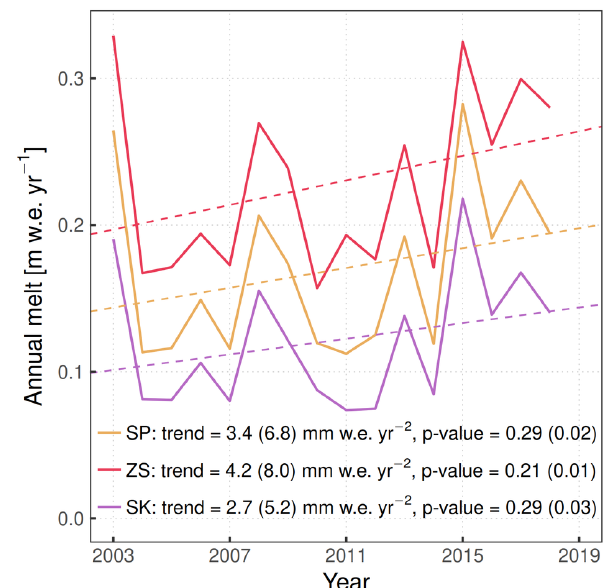
Figure 10. Time series of modeled annual melt amounts at three representative grid cells (solid lines; SP: saddle point, SK: Sig- nalkuppe slope, ZS: Zumsteinspitze slope). Linear least-squares fits (each including n = 16 annual values) are shown as dashed lines. Reported annual melt trends and corresponding p values are com- puted both on the whole 2003–2018 modeling period (first number) and excluding the extreme melt year of 2003 (second number, in parentheses). A 20m grid resolution and 1h time step are shown.